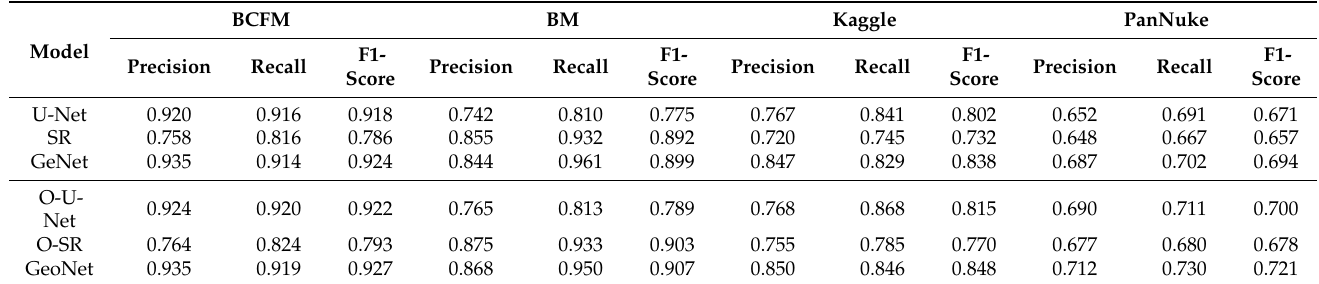
Table 3. Evaluation of cell localization for the unlabelled images of each data set.